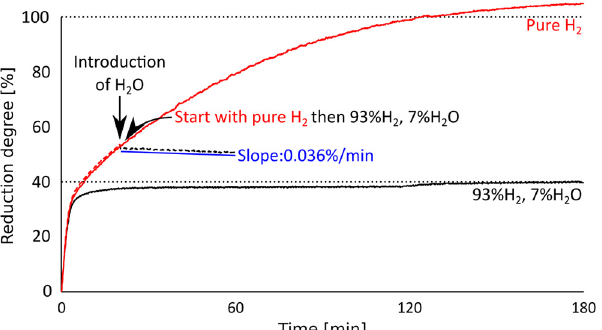
Figure 7. Reduction degree as a function of time for experiments 8 (pure H 2 ), 9 (pure H 2 , then H 2 -H 2 O) and 10 (H 2 -H 2 O) all carried out at 860 °C. The introduction of H 2 O in experiment 9 led to the reoxidation of iron.